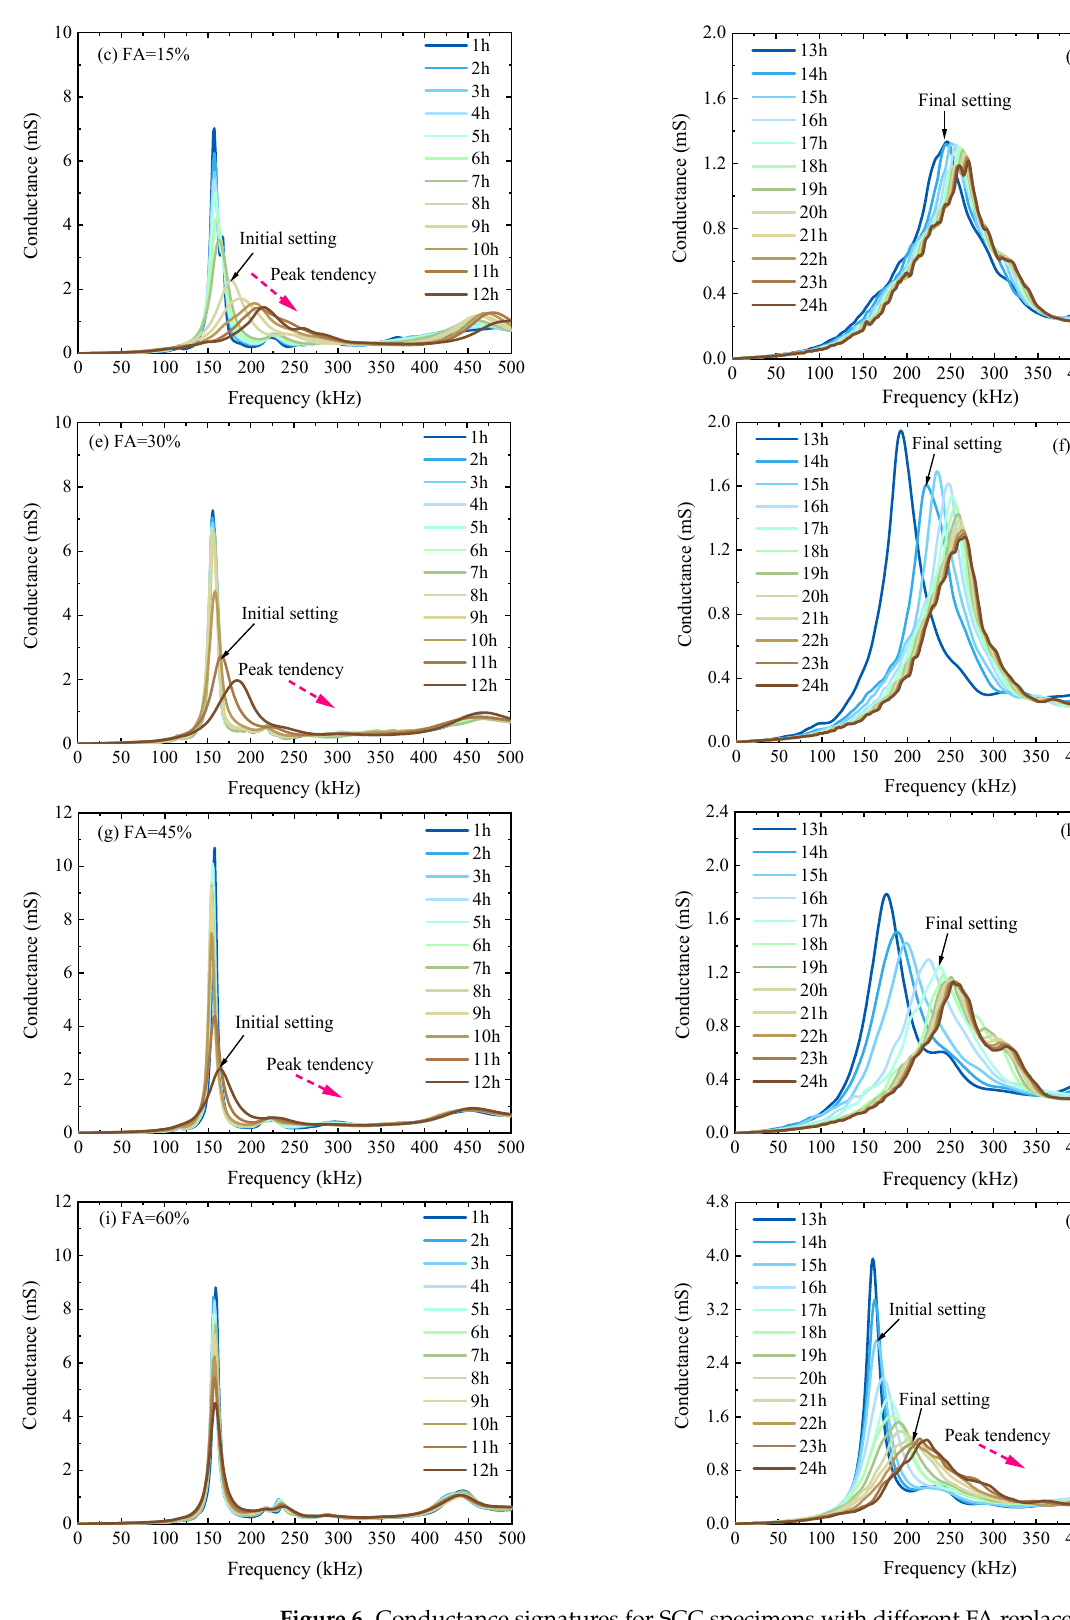
Figure 6. Conductance signatures for SCC specimens with different FA replacement ratios during curing from 1 h to 24 h. As indicated in Figure 6, each conductance signature has a predominant peak, re- flecting the resonance of the PZT sensor constrained by the SCC paste. With the increase